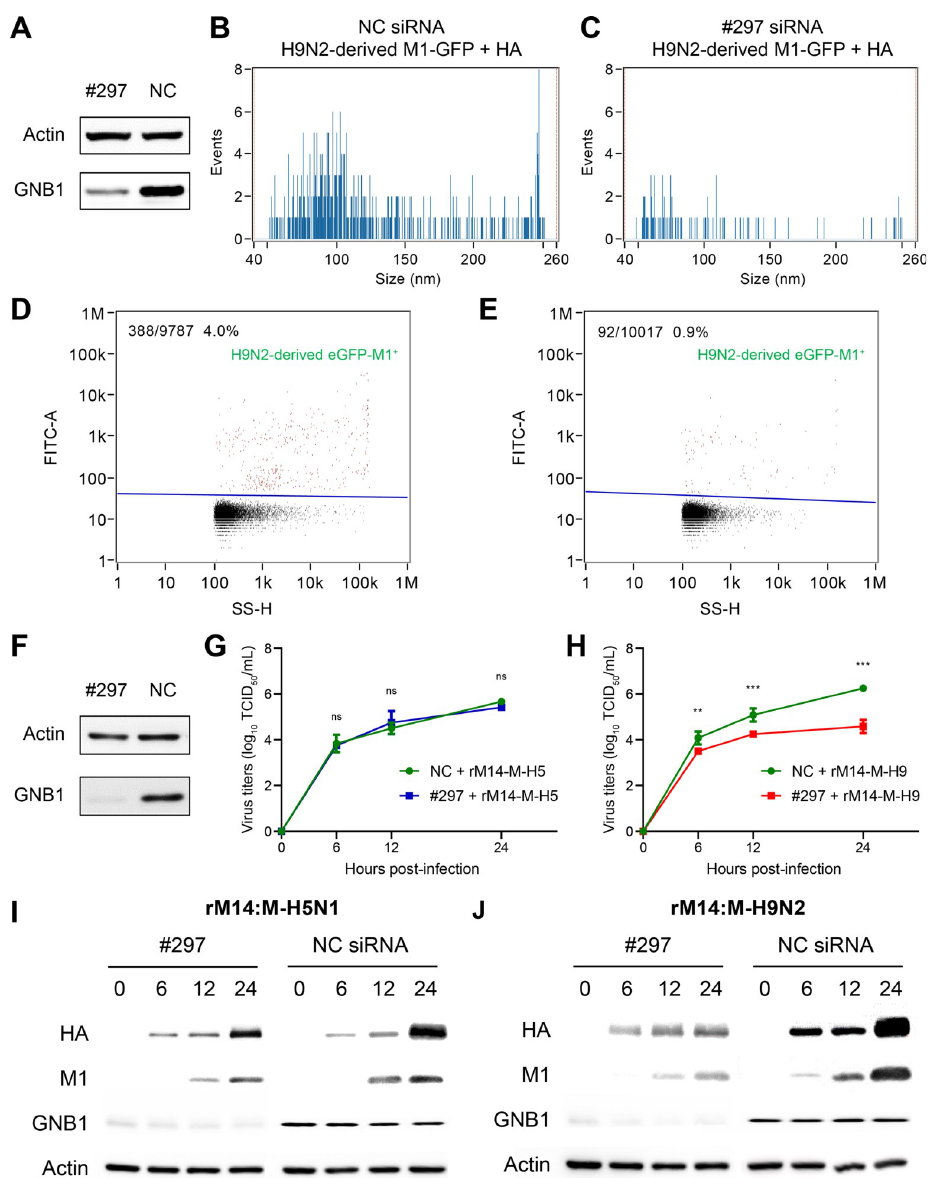
Fig 9. GNB1 protein contributed to viral particle release triggered by H9N2 virus-derived M1 protein. (A–E) Sizing and molecular profiling of VLP-associated H9N2-derived eGFP-M1 in #297 siRNA-induced GNB1-silenced or normal 293T cells. (A) A549 cells were transfected with siRNAs (targeting GNB1 or negative control), and GNB1 protein expression level at 36 h post-transfection were determined by Western blotting. (B–C) Size profiling of H9N2-derived eGFP-M1 + VLP particles with the FITC channel. (D–E) Molecular profiling of H9N2-derived eGFP-M1 + VLP particles. SS-H, side scatter height. (F–J) GNB1 knockdown decreased rM14:M-H9N2 virus replication in A549 cells. (F) GNB1 protein expression level at 36 h post-transfection determined by Western blotting. A549 cells transfected with siRNAs (either NC or GNB1-targeting siRNA #297) were infected with (G) rM14:M-H5N1 virus or (H) rM14:M-H9N2 virus at an MOI of 1. Viral titers were measured by TCID 50 assay at the indicated time points. Each data is represented as means ± SD and represents three independent experiments. ( �� , P < 0.01; ��� , P < 0.001; ns, no significance). A549 cells transfected with NC or GNB1-targeting siRNA #297 were infected with (I) rM14:M-H5N1 virus or(J) rM14:M-H9N2 virus at an MOI of 1, and expression of HA and M1 protein was measured by Western